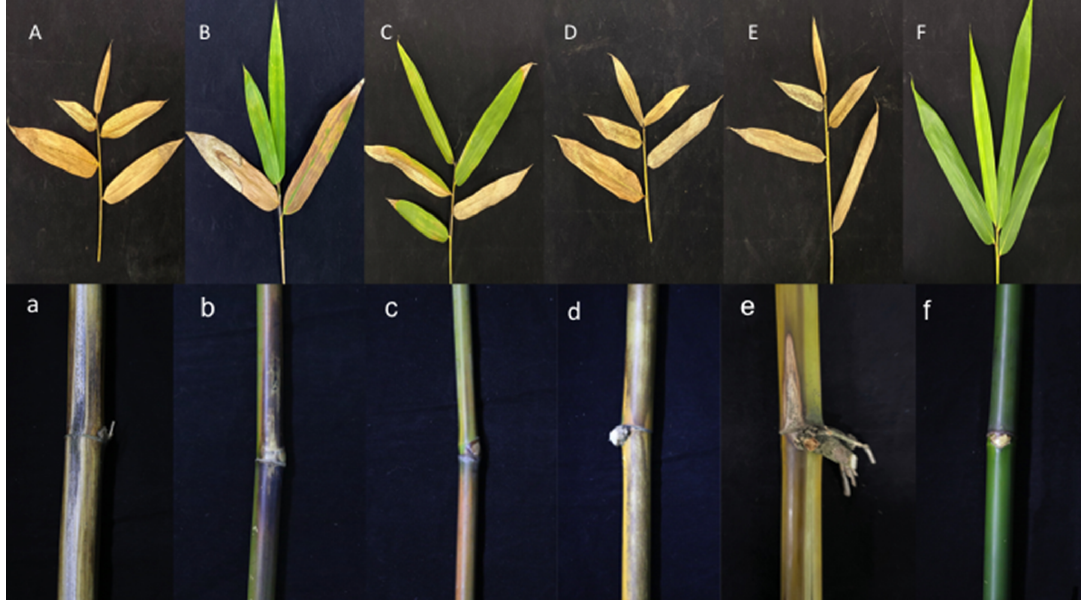
Figure 13. Symptoms of branches and leaves of plants infected with wild-type strain, Δ ApCE12 , Δ ApCE22 , ApCE12 complementary strain, ApCE22 complementary strain, and sterile water after 25 days. Note: ( A , a ) are the symptoms of B. pervariabilis × D. grandis leaves and branches inoculated with wild-type strain for 25 days, respectively. ( B , b ) are the symptoms of B. pervariabilis × D. grandis leaves and branches inoculated with Δ ApCE12 strain for 25 days, respectively. ( C , c ) are the symptoms of B. pervariabilis × D. grandis leaves and branches inoculated with Δ ApCE22 strain for 25 days, respectively. ( D , d ) are the symptoms of B. pervariabilis × D. grandis leaves and branches inoculated with ApCE12 complementary strain for 25 days, respectively. ( E , e ) are the symptoms of B. pervariabilis × D. grandis leaves and branches inoculated with ApCE22 complementary strain for 25 days, respectively. ( F , f ) are the symptoms of B. pervariabilis × D. grandis leaves and branches inoculated with sterile water for 25 days, respectively.